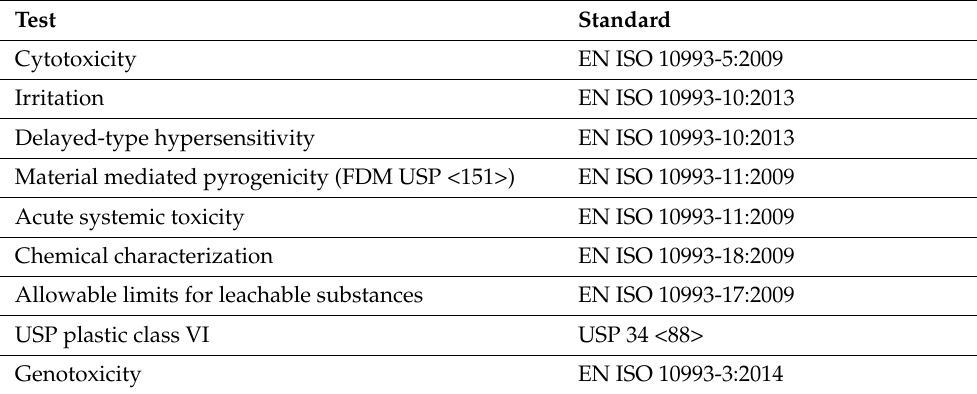
Table 1. Biomaterials